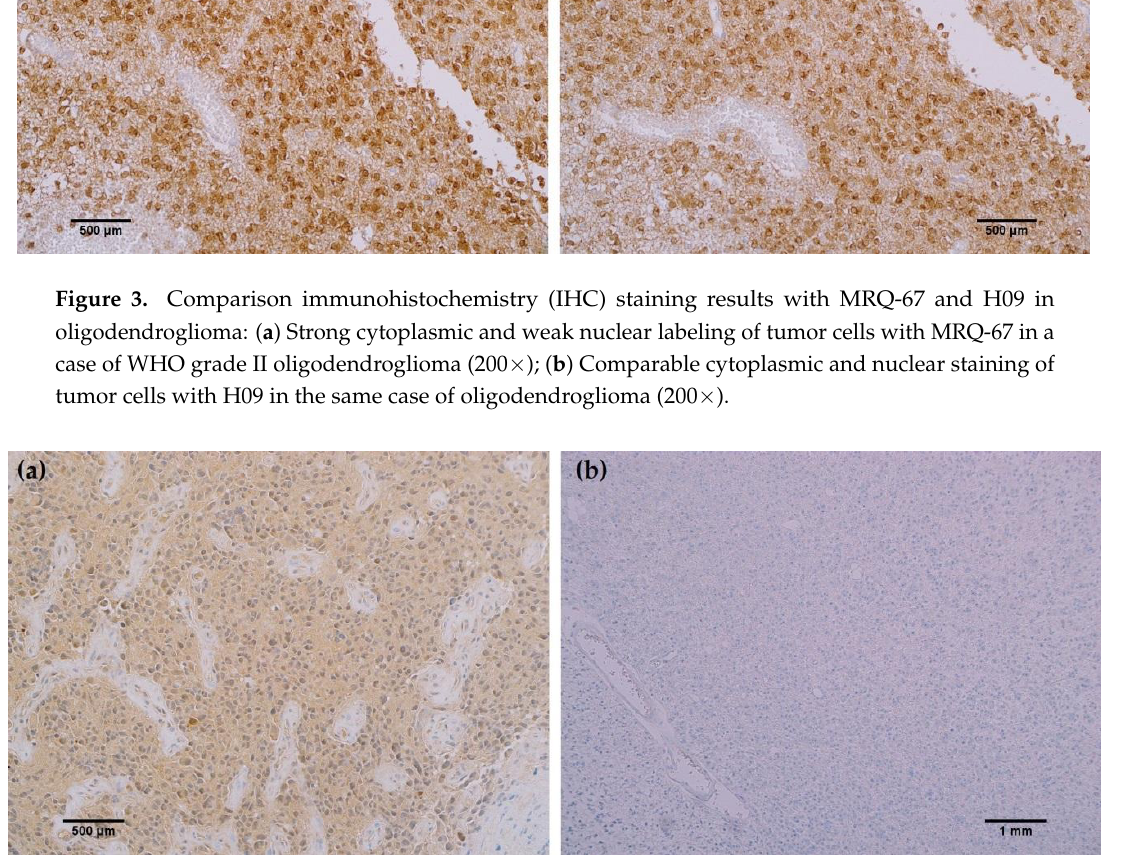
Figure 4. MRQ-67 immunohistochemistry (IHC) staining results in high grade glioblastoma: ( a ) Weak, diffuse cytoplasmic and nuclear labeling of tumor cells in a case of WHO grade IV glioblastoma with anaplastic astrocytoma involvement (200×); ( b ) No observed reactivity in tumor cells in another case of WHO grade IV glioblastoma (100×).